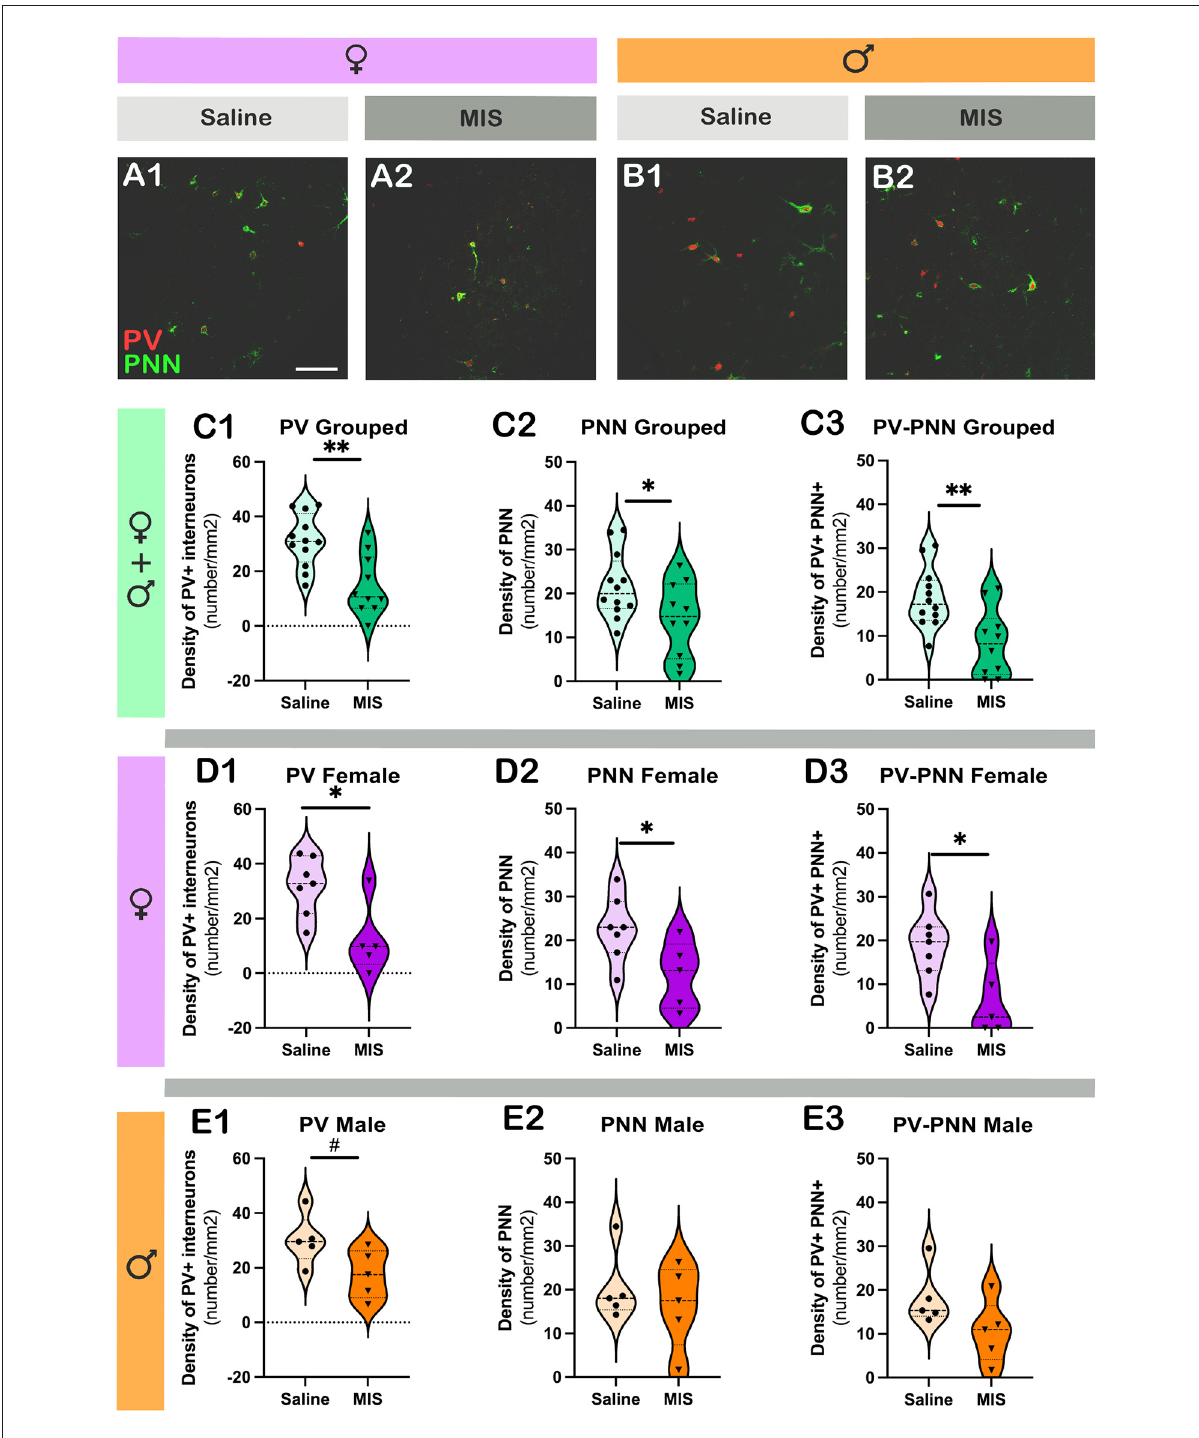
FIGURE5 Analysis of the density of parvalbumin+ interneurons (PV) and perineuronal nets (PNN) in the basolateral amygdala. (A,B) Representative single confocal planes of parvalbumin+ interneurons (red, PV) and perineuronal nets (green, PNN) of control and MIS treated rats in females (A) and males (B) . (C–E) Graphs representing the effects of poly I:C on the density of PV + interneurons (C1–E1) , PNN (C2–E2) , and PV+ cells surrounded by PNN (C3–E3) . Graphs in the first row (green) include data from all experimental animals (not separated by sex) (Saline: n = 12, MIS: n = 10). Graphs in the second row (purple) include data from females (Saline: n = 7, MIS: n = 5). Graphs in the third row (orange) include data from males (Saline: n = 5, MIS: n = 5). Values represent mean ± S.E.M. Asterisks in graphs indicate statistically significant effects between groups (Saline x MIS) after unpaired Student’s t -test. Symbols: # 0.1 > p > 0.05; ∗ p < 0.05; ∗∗ p < 0.01; Scale bar 100 µ